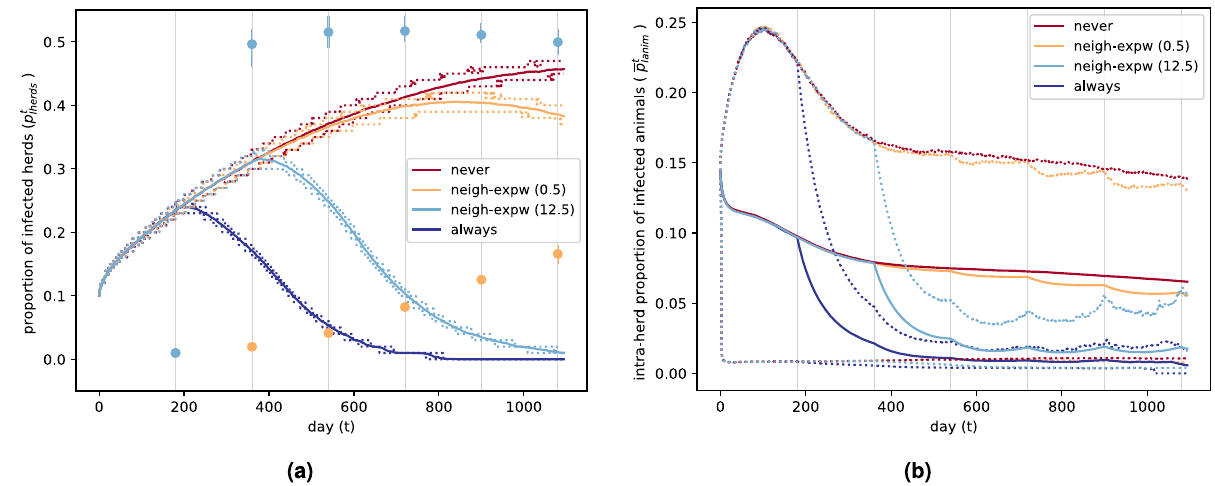
Figure 3. Temporal dynamics of the epidemic spread for each vaccination scenario over 50 runs. Each decision instant is represented by a vertical grey line. ( a ) Inter-herd prevalence. Mean over runs (solid lines), 10th and 90th percentiles over runs (dotted lines). Mean proportion of herds that vaccinate at each decision-time in each neigh-expw scenario (light blue and orange dots), and its variation over runs (from the 10th to the 90th percentile in light blue and orange vertical lines). ( b ) Intra-herd prevalence for infected herds. Mean over runs of the means over infected herds (solid lines), 10th percentile over runs of the 10th percentiles over infected herds, and 90th percentile over runs of the 90th percentiles over infected herds (dotted